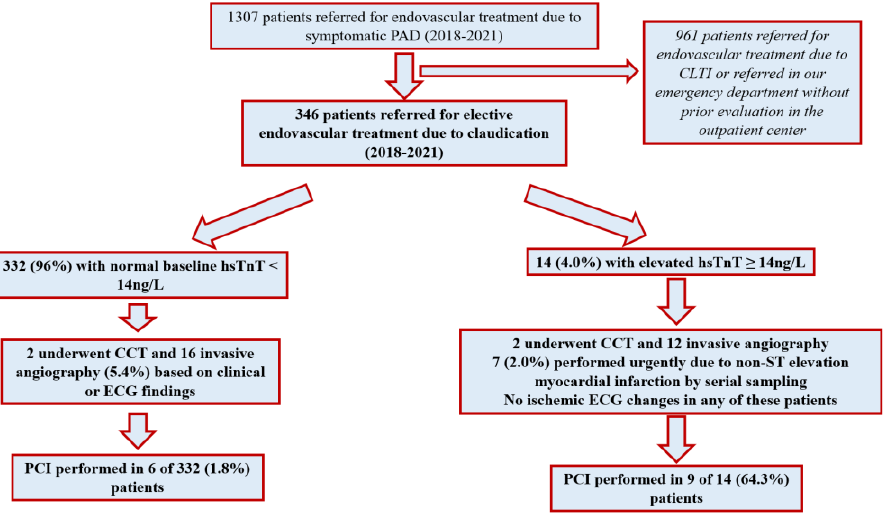
Figure 1. Flow chart of our study, including inclusion of patients with PAD and further clinical management regarding cardiac work-up and coronary revascularization. management regarding cardiac work-up and coronary revascularization.